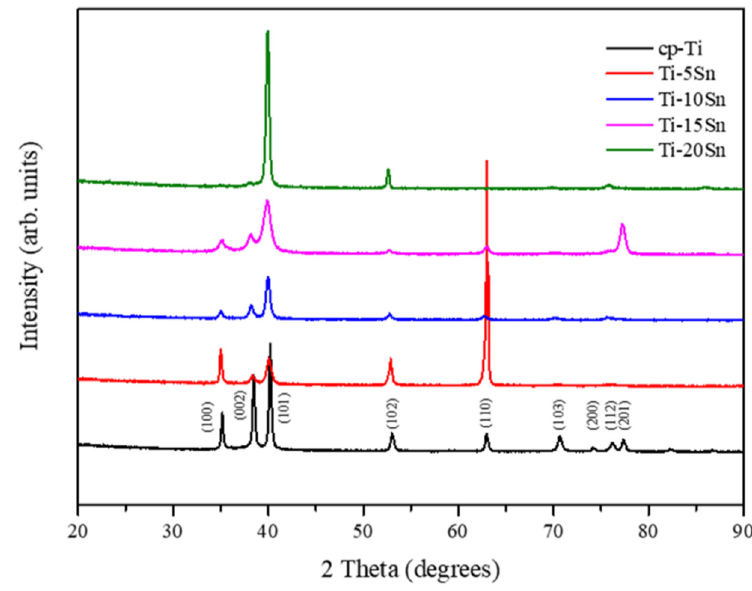
Figure 1. XRD patterns of cp-Ti and Ti-xSn alloys (x = 5~20 wt%).